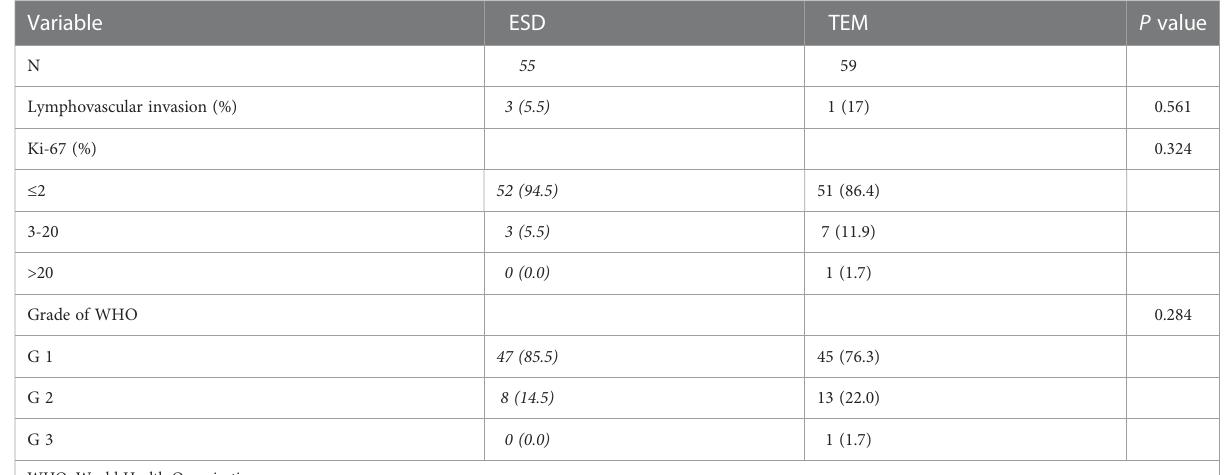
TABLE 3 Post-operative pathological assessment and tumor